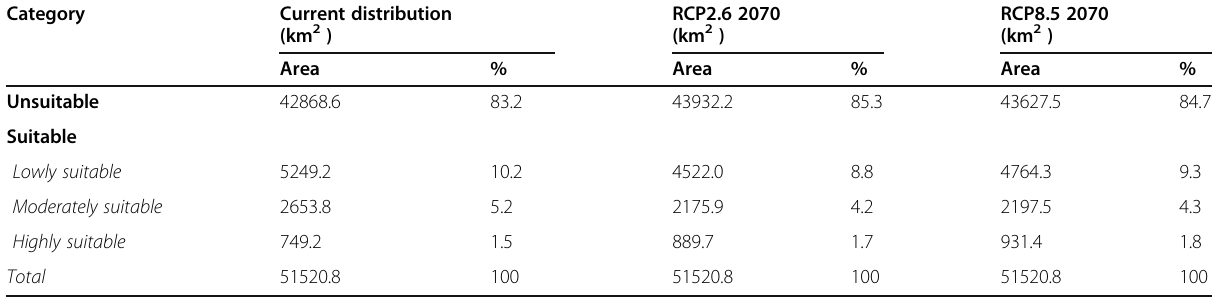
Table 4 Model outputs indicating the probability of habitat suitability and unsuitability areas (percentage) for the current and